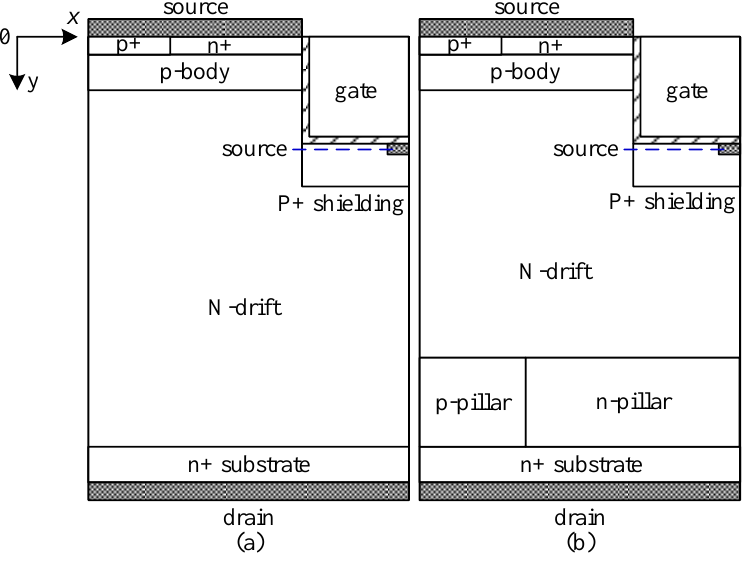
Figure 1. Cross-sectional schematic of a half-cell in ( a ) C-UMOS and ( b ) BSJ-UMOS.